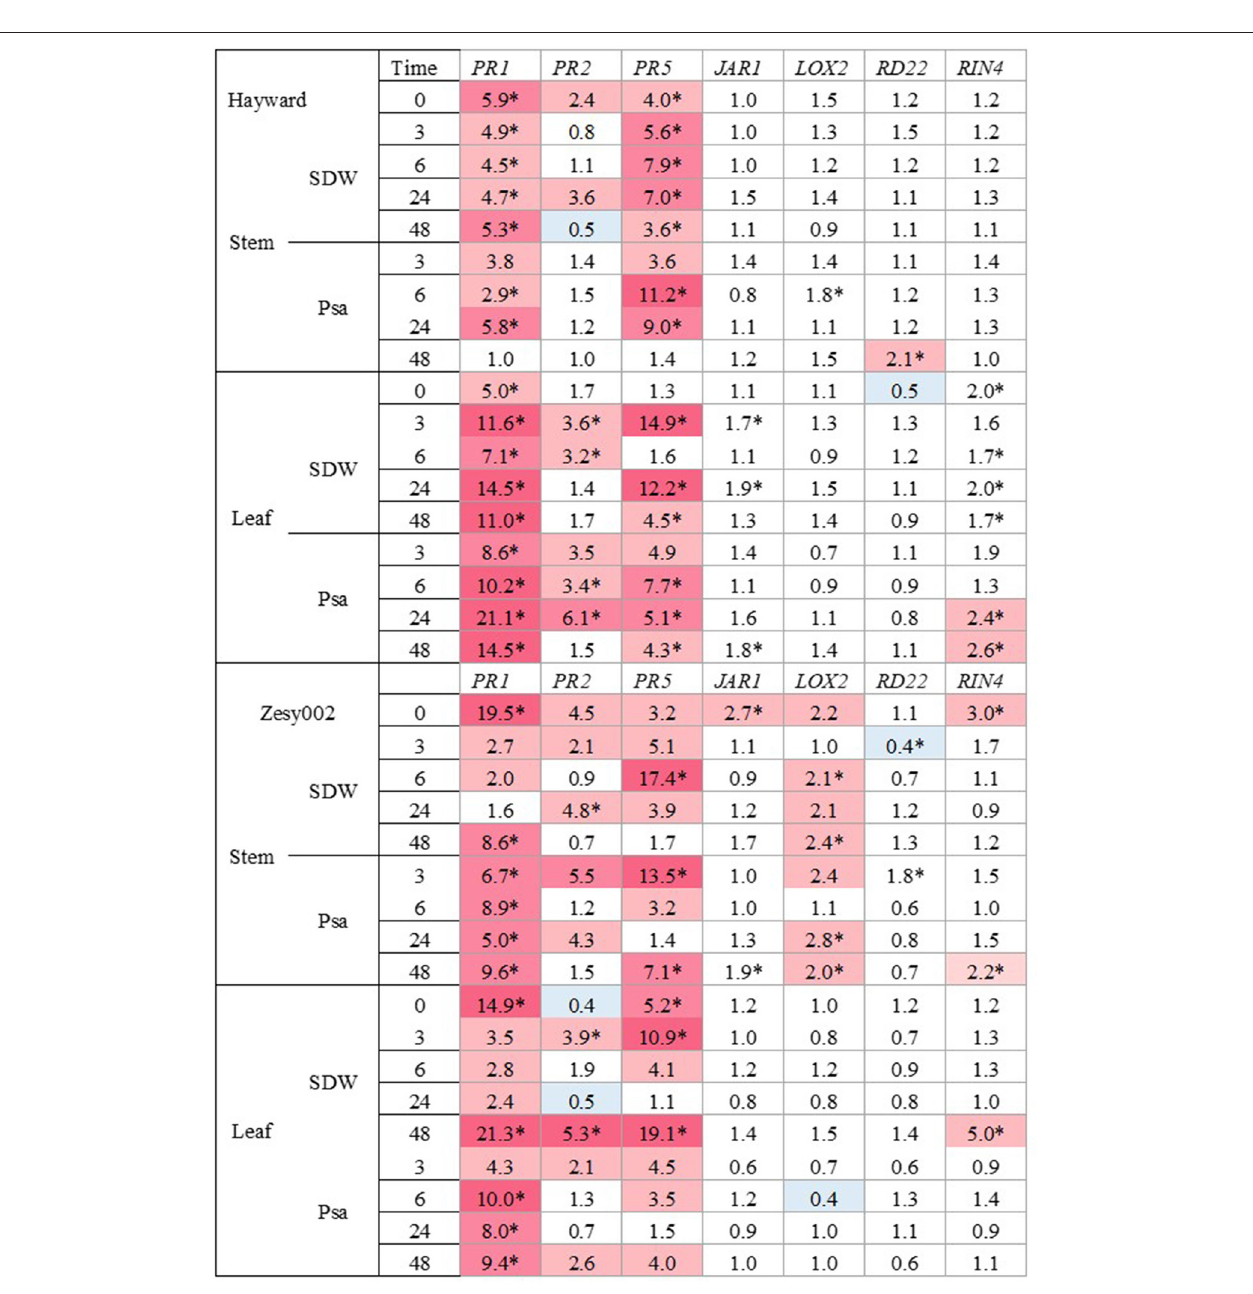
FIGURE 1 | Fold-change in gene expression induced by Actigard at the stem inoculation site and in the adjacent leaf in glasshouse-grown Actinidia chinensis var. deliciosa ‘Hayward’ plants and A. chinensis var . chinensis ‘Zesy002’ plants before (T = 0h) and at 3, 6, 24, and 48h after inoculation with sterile distilled water (SDW) or a suspension of Pseudomonas syringae pv. actinidiae (Psa). Plants were sprayed with water (Con) or with 0.2 g/L Actigard (ASM) 1 week before inoculation. Gene expression was quantified by quantitative PCR (qPCR) using 40S rRNA ( 40S ) and ubiquitin-conjugating enzyme ( UBC1 ) as the reference genes. The analysis was performed at the log 2 scale and the heat map shows the relative ratio of transcript levels between Actigard-treated plants and the control. Significant differences at individual time points are identified with an asterisk ( p <